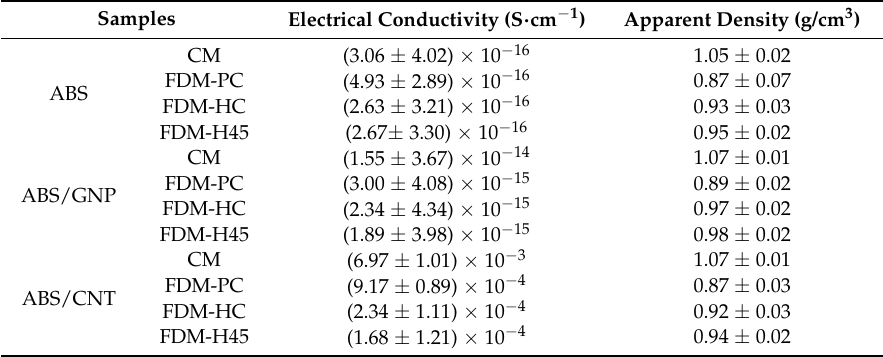
Table 2. Electrical conductivity and apparent density of ABS and its composites.